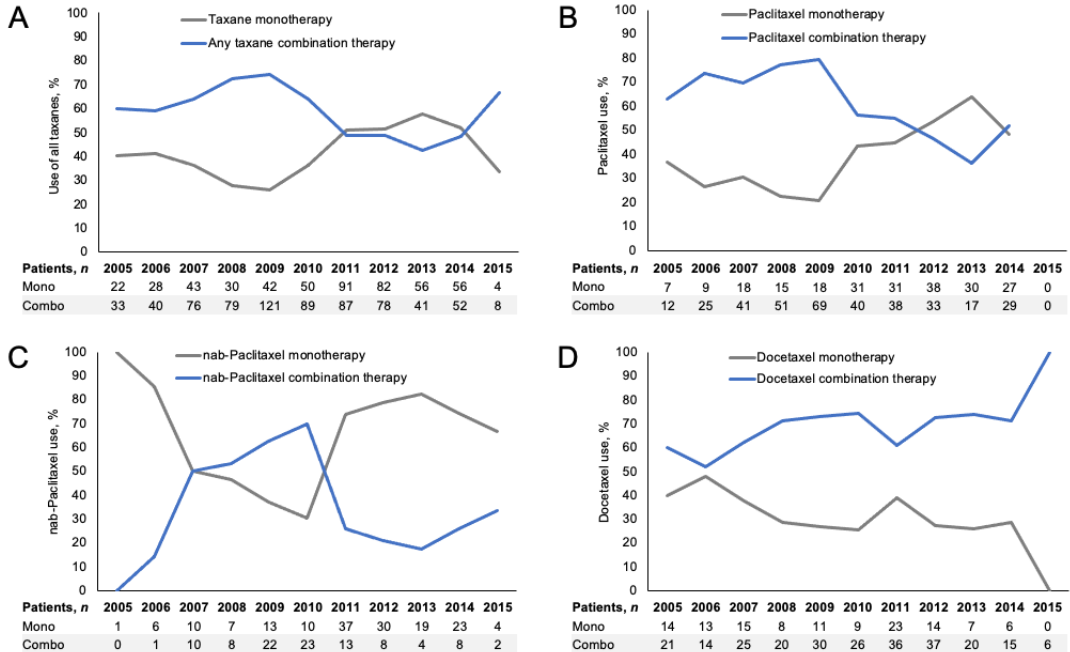
Figure 1. Use of taxane monotherapy and combination therapy in 1L mTNBC by year (2005–2015): ( A ) all taxanes, ( B ) paclitaxel, ( C ) nab -paclitaxel, and ( D ) docetaxel. Proportions are plotted, with absolute numbers shown below the plots. At the time of the analysis, treatment use data were available only through 30 June 2015. 1L: first line, mTNBC: metastatic triple-negative breast